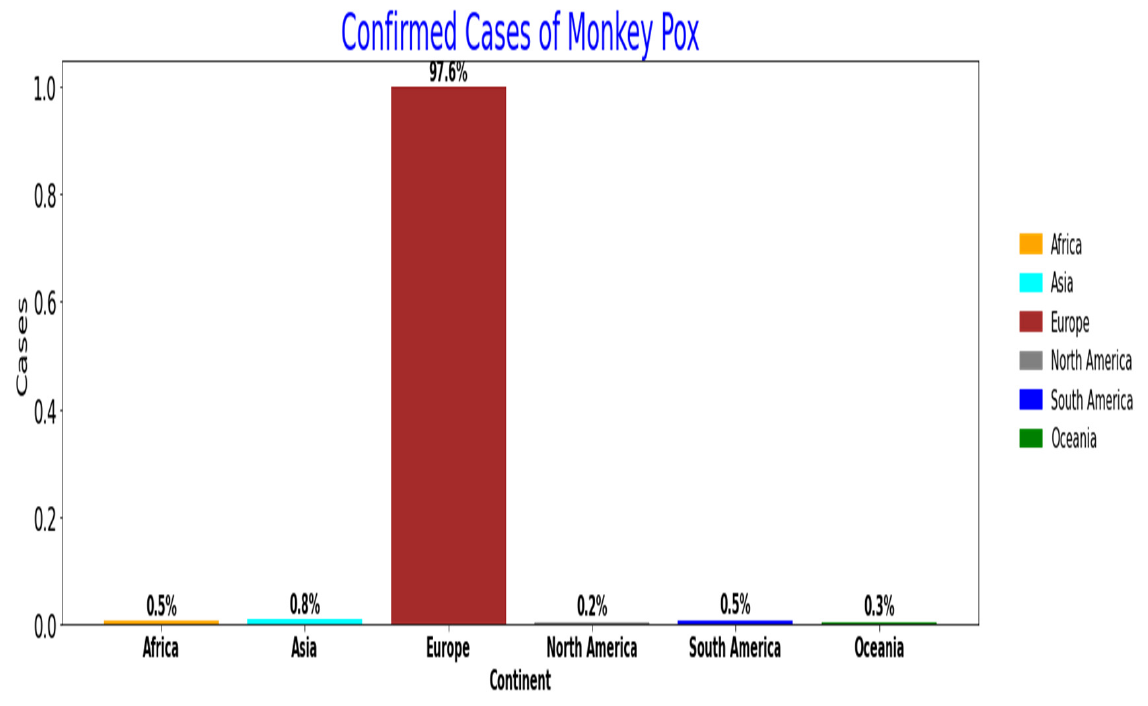
Figure 3. Confirmed Cases of Monkey pox.